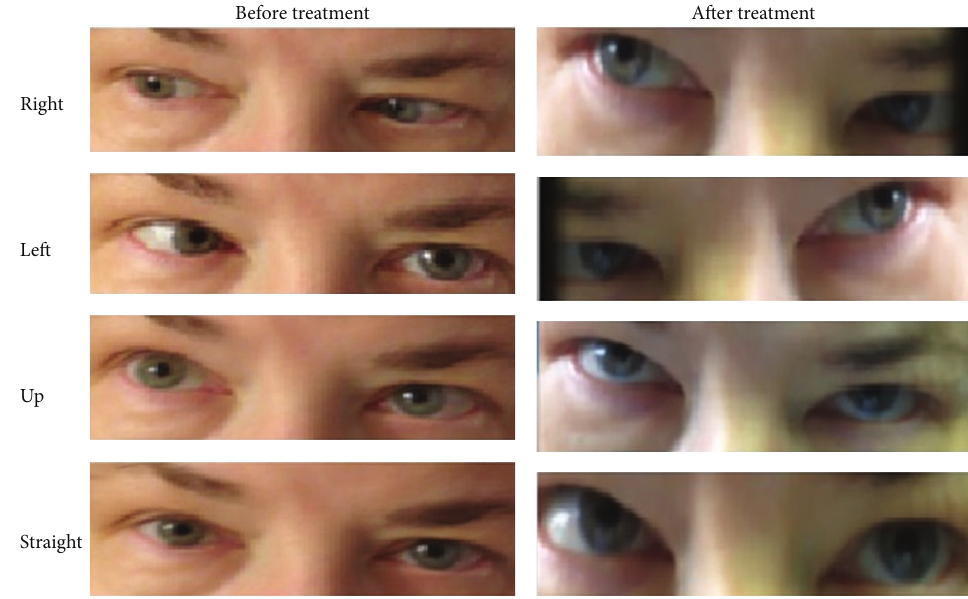
Figure 1: This image shows extraocular movements before and after the treatment.